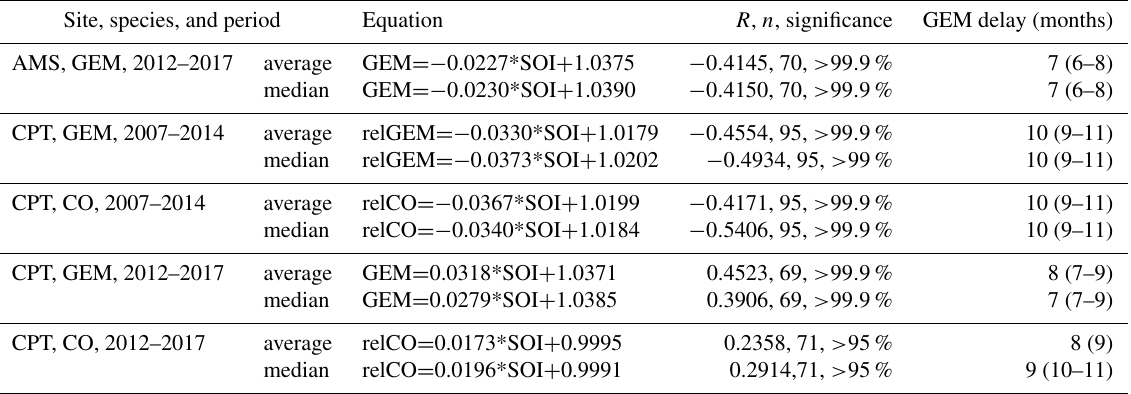
Table 4. Correlation of 3-month running average and median GEM concentrations and CO mixing ratios with 3-month running average of SOI (https://www.cpc.ncep.noaa.gov/data/indices/soi.3m.txt (last access: 19 June 2019). The CPT GEM data for 2007–2014 were detrended and the CPT CO data for 2007–2014 and 2012–2017 deseasonalised using the average monthly averages or medians over the period. No CO correlation is presented for AMS because CO data are available only from December 2015 until December 2017. The delay given in the last column is the one with the highest R . The delays in the brackets are significant correlations with the second- and third-highest R . Site, species, and period Equation R , n ,